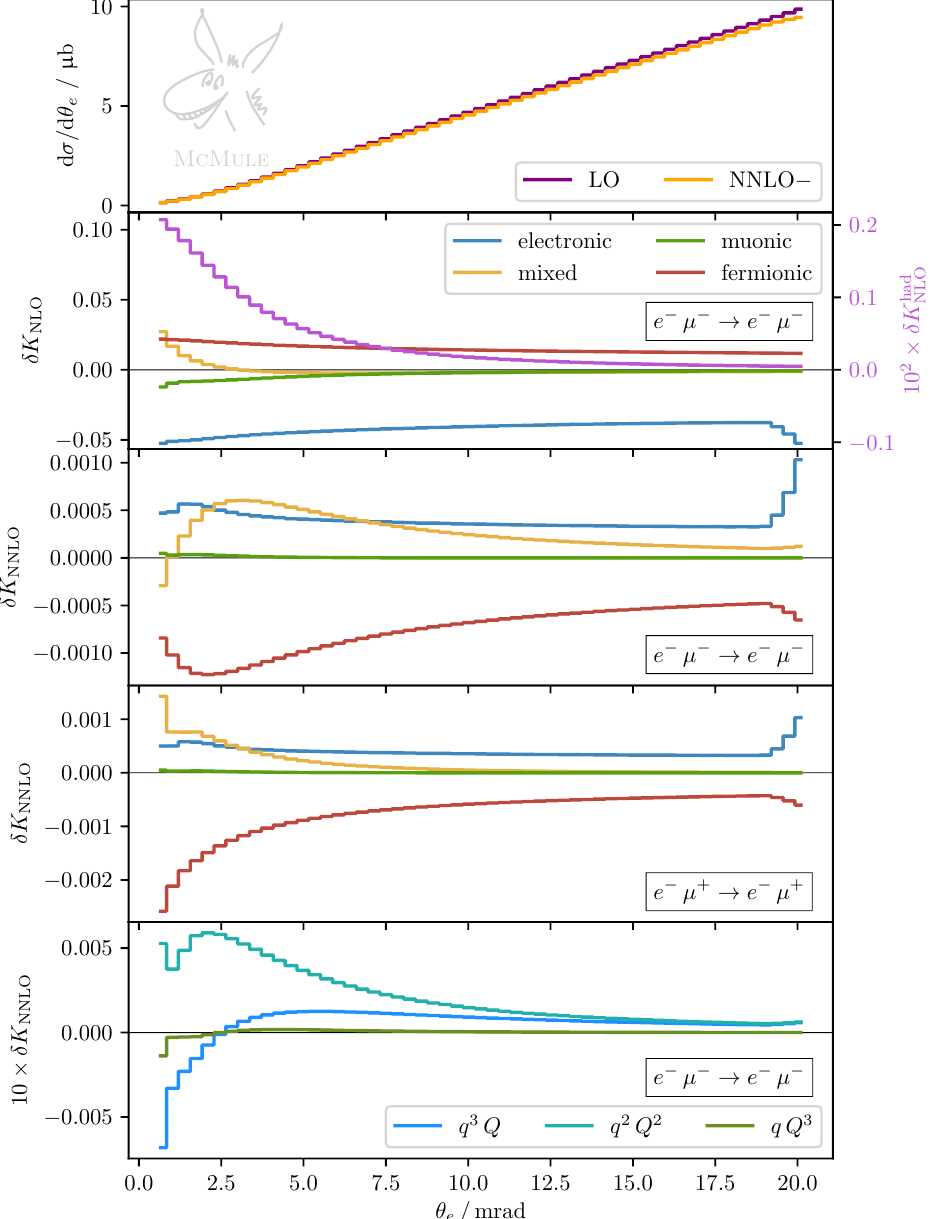
Figure 4 . From top to bottom: (i) differential cross section w.r.t. θ e for S2 at LO (violet), and NNLO (orange) for negative muons; (ii) NLO K factor for negative muons (positive muons have a sign flip for the mixed photonic correction); (iii) NNLO K factor for negative muons; (iv) NNLO K factor for positive muons; (v) NNLO K factor for disentangled mixed photonic corrections, for negative muons. In panels (ii)–(iv) the correction is split into photonic, i.e. electronic, mixed and muonic, and fermionic, including leptonic and hadronic. The hadronic correction at NLO corresponds to the signal of the experiment and is shown separately in purple in panel